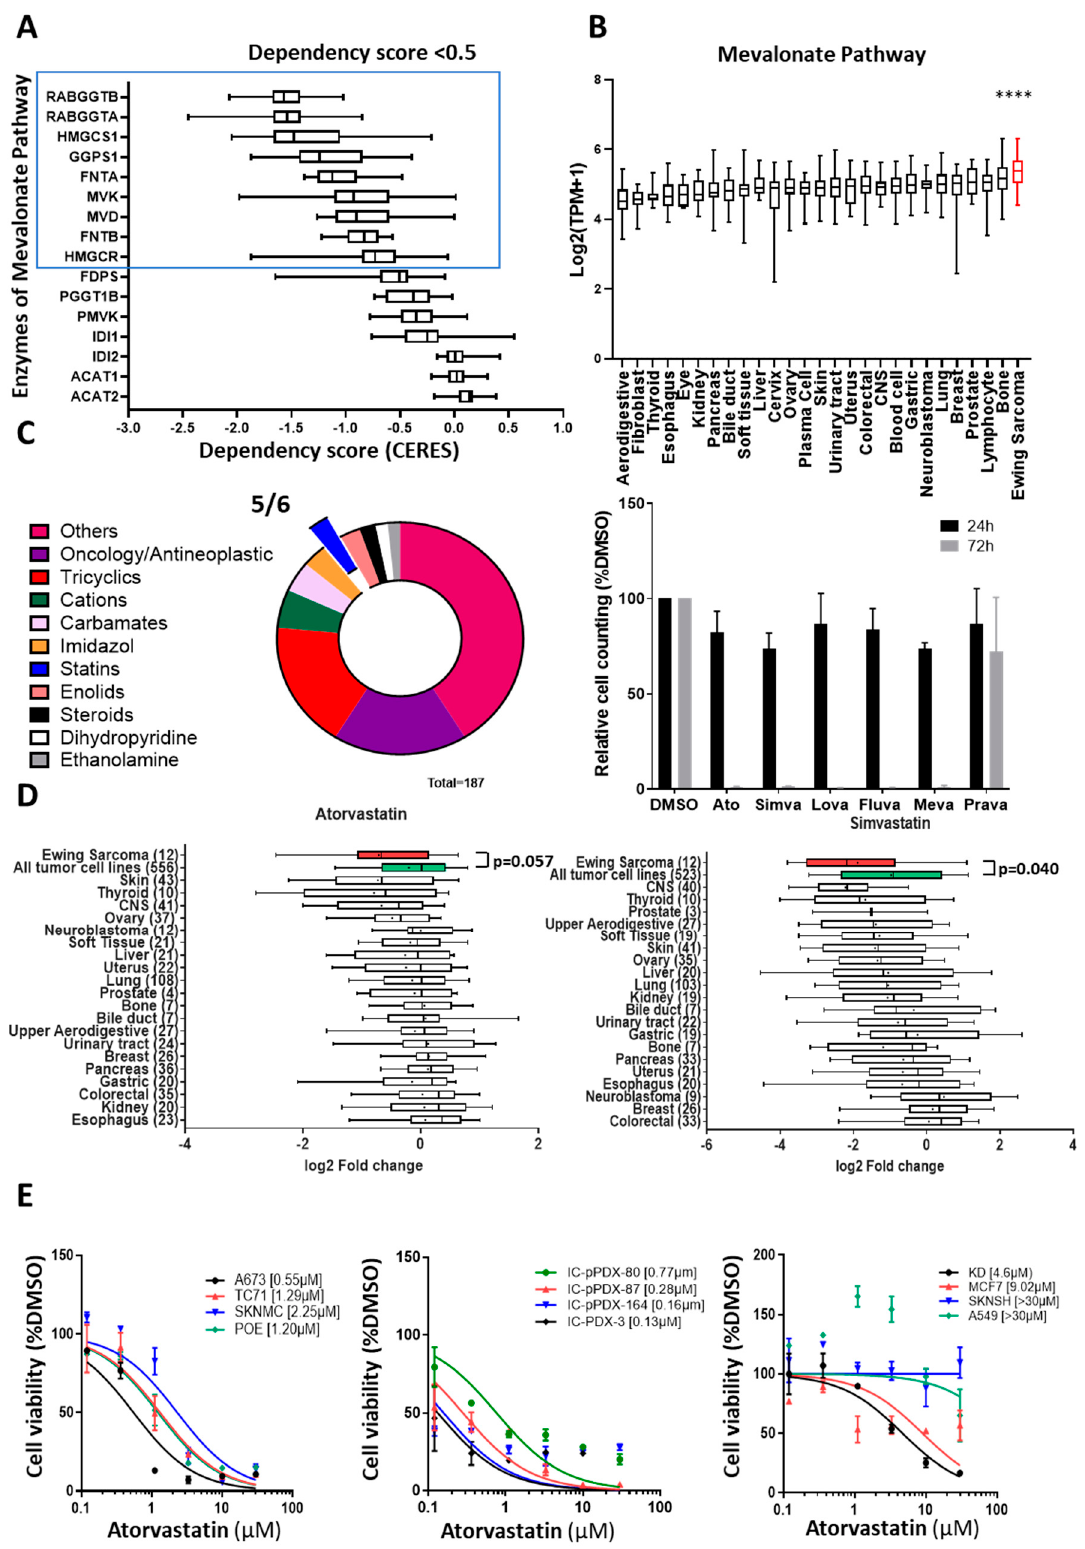
Figure 3. Ewing sarcoma tumors and cell lines are sensitive to statin treatment. ( A ) Boxplot of median dependency scores for mevalonate pathway enzymes and prenyltransferases in 25 Ewing sarcoma cell lines upon CRISPR lethality screening (DepMap portal, Avana library). The blue box highlights genes with a median dependency score < − 0.5 in Ewing cell lines. ( B ) Comparison of the mean expression level of mevalonate pathway enzymes and prenyltransferases across various tumor cell lines (DepMap portal) [33]. Data are presented as min-to-max boxplots with median; **** p value <